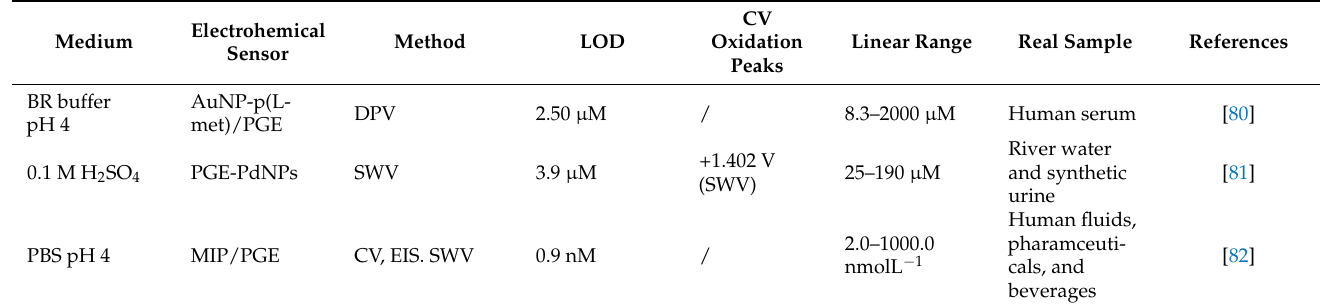
Table 3. Electrochemical characteristics of pencil graphite electrode as sensor for caffeine determina-